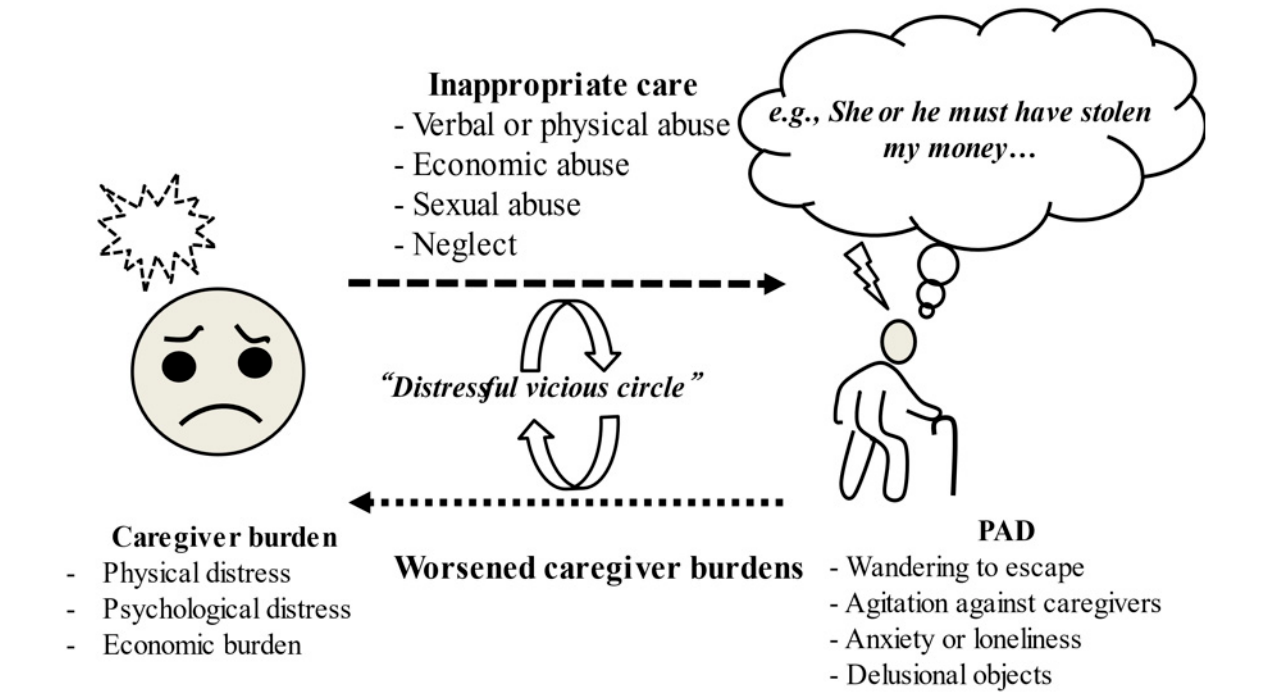
Figure 3. Caregiver burden and NPS interact to create a “ distressful vicious circle ” between the caregiver and the PAD, causing a deterioration in their interpersonal relationship. While caregiver burden, including physical distress and psychological frustrations arising from the care of dementia patients, can be causative factors leading to severe NPSs, these factors may also occur as a response to severe NPSs, creating a “distressful vicious circle” between the caregiver and the patient and disrupting favorable interrelationships. Abbreviations: NPSs: neuropsychiatric symptoms, PAD: patient with Alzheimer’s disease.